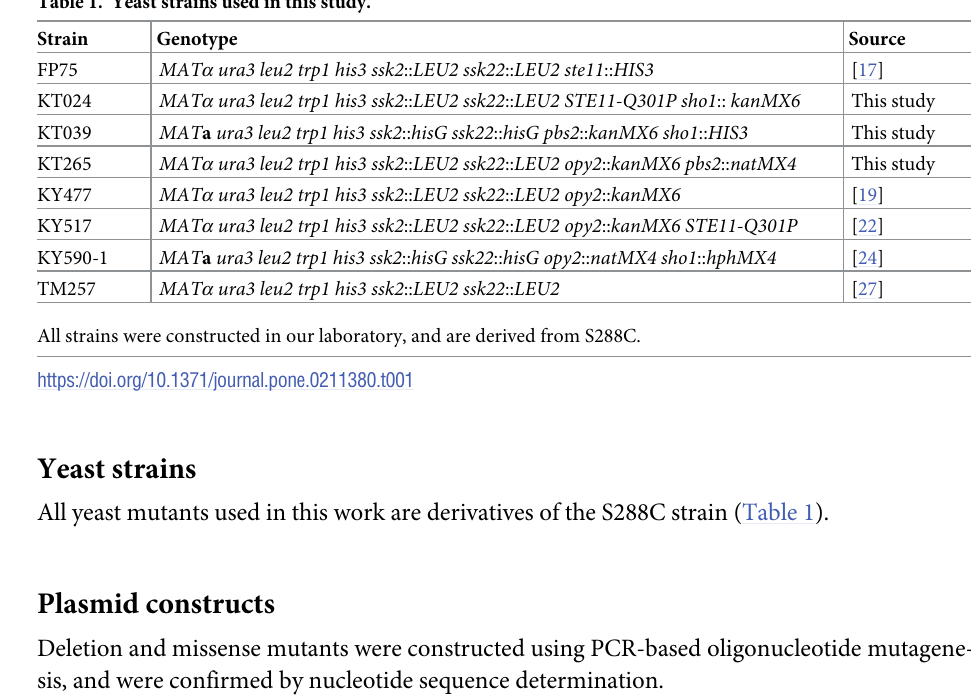
Table 1. Yeast strains used in this study. Strain